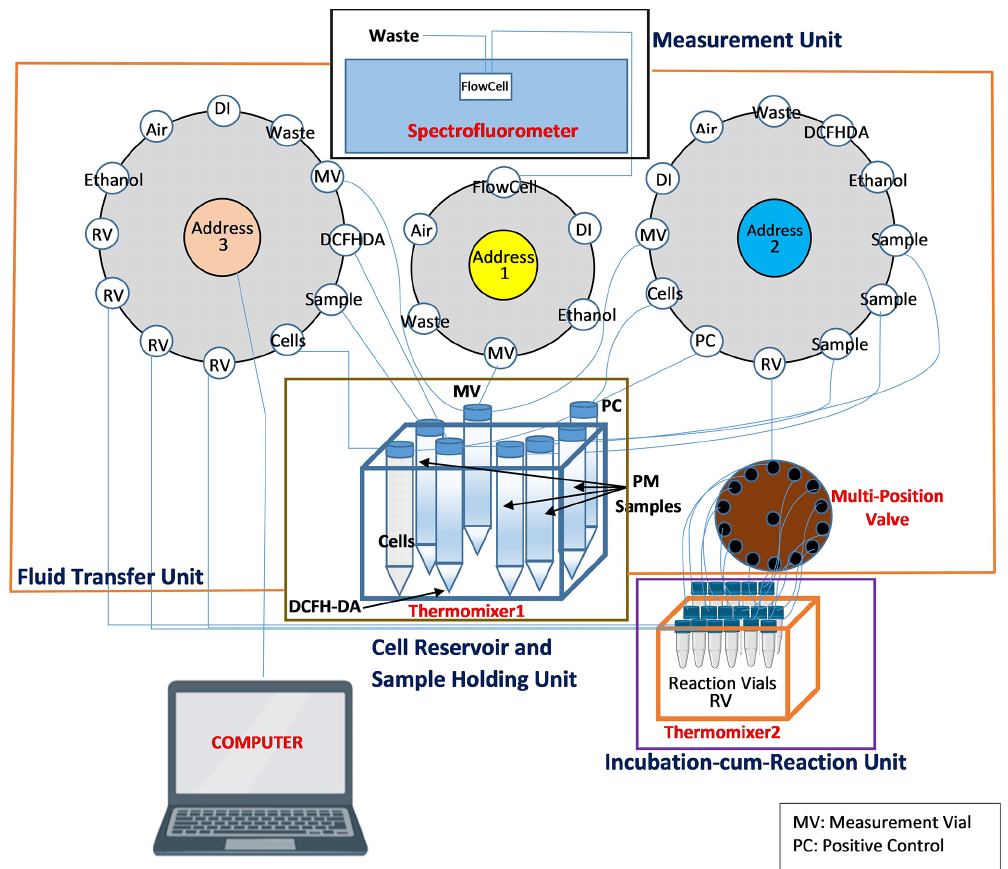
Figure 1. Automated system setup. The instrument consists of four major units: cell reservoir and sample holder, fluid transfer unit, incubation-cum-reaction unit and the measurement unit. The cell reservoir and sample holder unit consists of a set of several vials, con- taining cells, DCFH-DA solution and the samples, all kept in thermomixer 1. The fluid transfer unit consists of three syringe pumps (pump no. 1, 2 and 3) and a 14-port multi-position valve connected to pump no. 2. The incubation-cum-reaction unit consists of 17 reaction vials (RVs), held in thermomixer 2. The measurement unit consists of a spectrofluorometer equipped with a flow